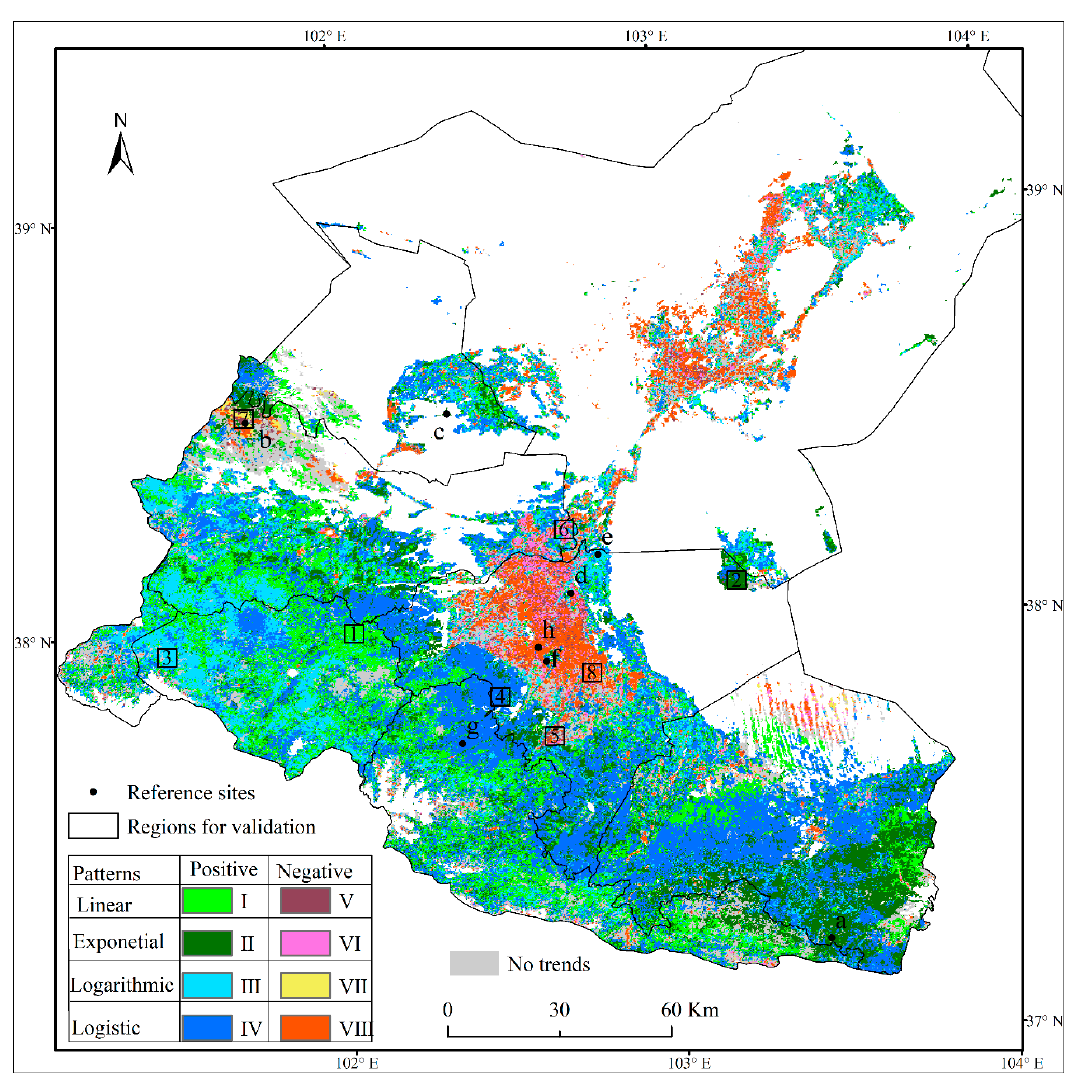
Figure 3. Patterns of vegetation (NDVI max ≥ 0.2) gradual changes in the Shiyang River Basin during the period 2001–2017. There are four patterns: linear pattern, exponential pattern, logarithmic pattern, and logistic pattern. Each pattern is further divided into two types according to the trend in NDVI timeseries, which is determined by the parameter b in Equation (4) or the slope value in Equation (6). The eight reference sites and eight regions selected for validation are also shown in this figure. Table 2. Coverage of vegetation (NDVI max ≥ 0.2) change patterns in the Shiyang River Basin based on our framework. Each pattern is divided into two types according to the positive or negative trend in NDVI timeseries.